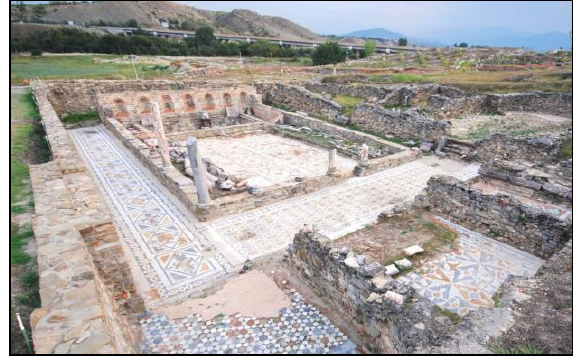
Figure 2. The Theodosian